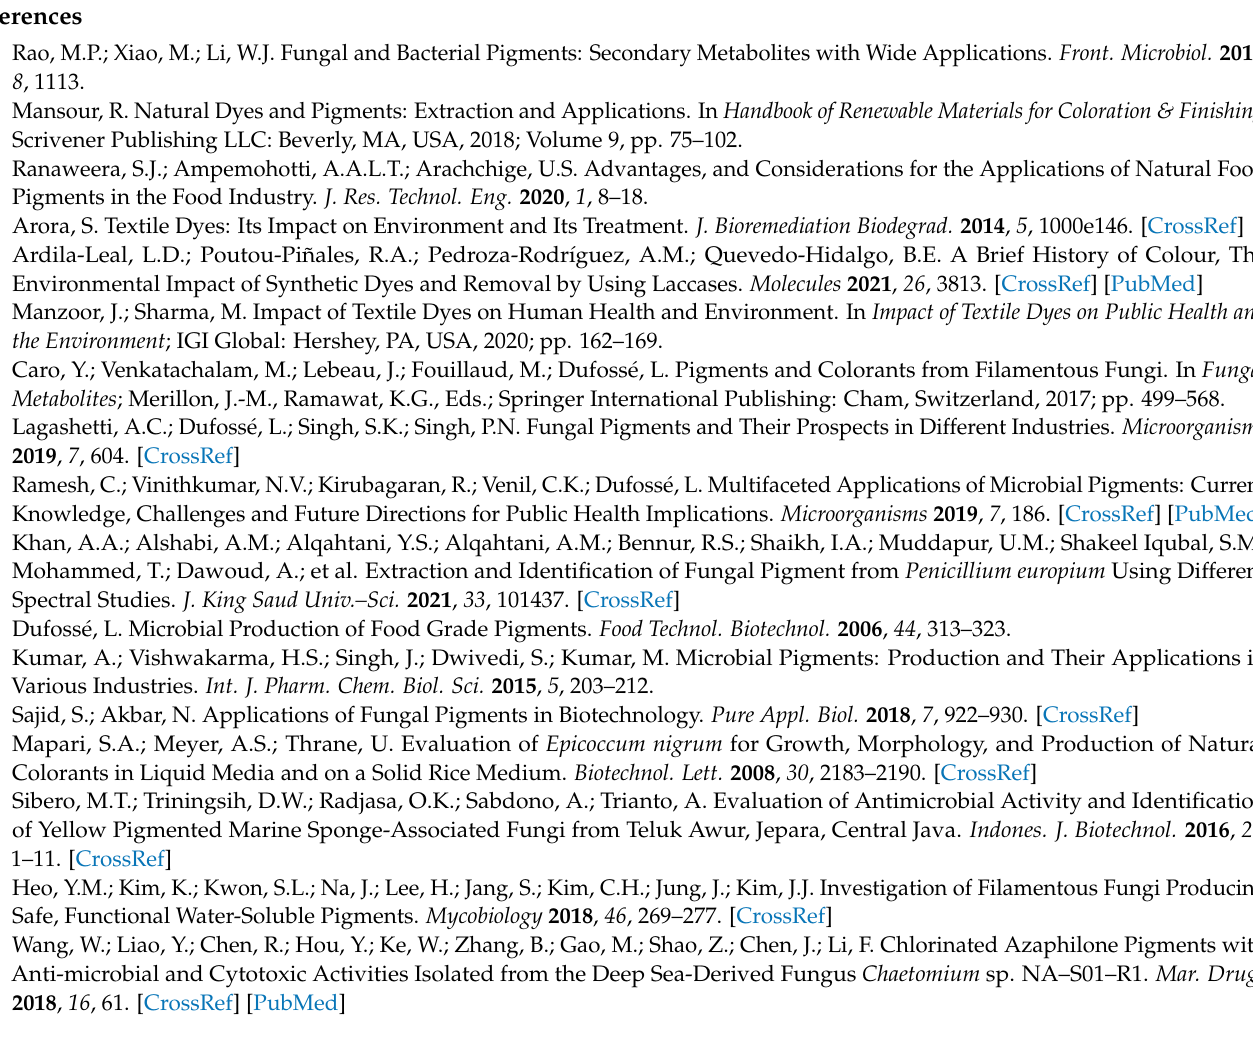
Supplementary Materials: FTIR (Figure S1), HR-MS (Figure S2), 1 H NMR (Figure S3), COSY (Figure S4), 13 C NMR (Figure S5), and DEPT-135 (Figure S6) spectra for compound 1,2-dimethoxy-3 H -phenoxazin- 3-one and GC-MS chromatogram (Figure S7) of hexane extract